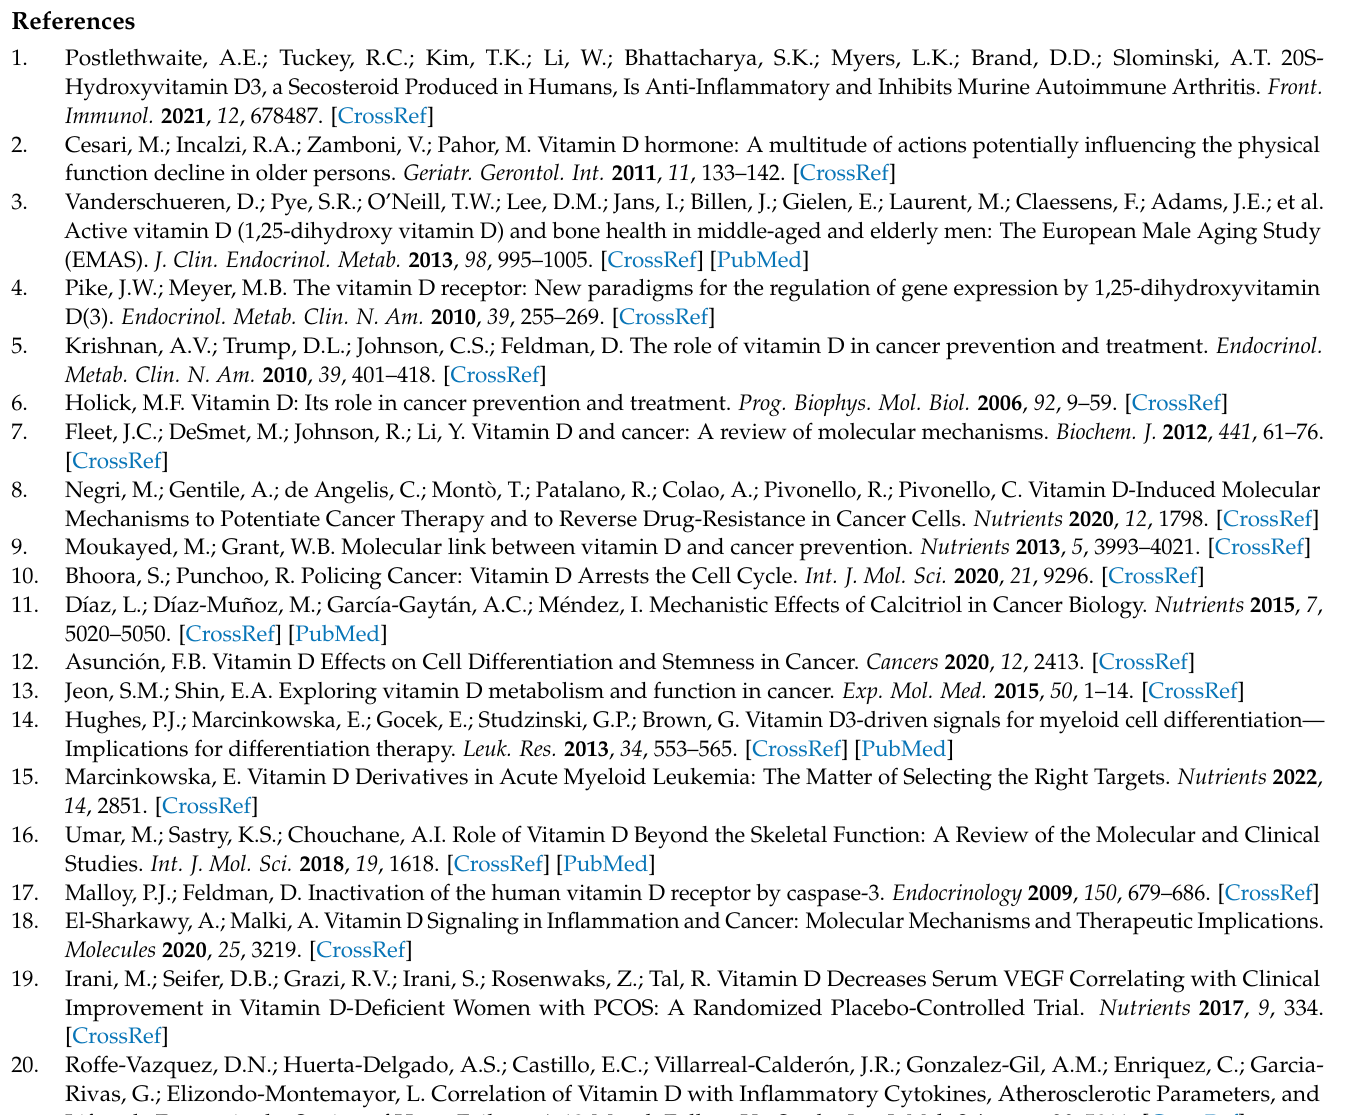
CAR-T, chimeric antigen receptor T-cell; OS, overall survival; DFS, disease-free survival; IU, international units; FL, follicular lymphoma; HL, Hodgkin lymphoma; IL, interleukin; NR, not reported; OR, odds ratio; HR, hazard ratio; DLBCL, diffuse large B-cell lymphoma; TCL, T-cell lym- phoma; NS, not significant; LC-MS/MS, liquid chromatography–tandem mass spectrometry; CLIA, chemiluminescence immunoassay; RIA, radioimmunoassay; ELISA, enzyme-linked immunosor- bent assay; CLIA, chemiluminescence immunoassay; ECL, electrochemiluminescence; BCL, B-cell lymphoma; MCL, mantle cell lymphoma; MZL, marginal zone lymphoma; LPL, lymphoplasma- cytic lymphoma; BL, Burkitt lymphoma, NHL, non-Hodgkin lymphoma; CLL, chronic lymphocytic leukemia; TTT, time to treatment; ENKTL, extranodal natural killer/T-cell lymphoma; CS, complete response; PRISMA, Preferred Reporting Items for Systematic Reviews and Meta-Analyses; PROS- PERO, Prospective Register of Systematic Reviews; OSF, Open Science